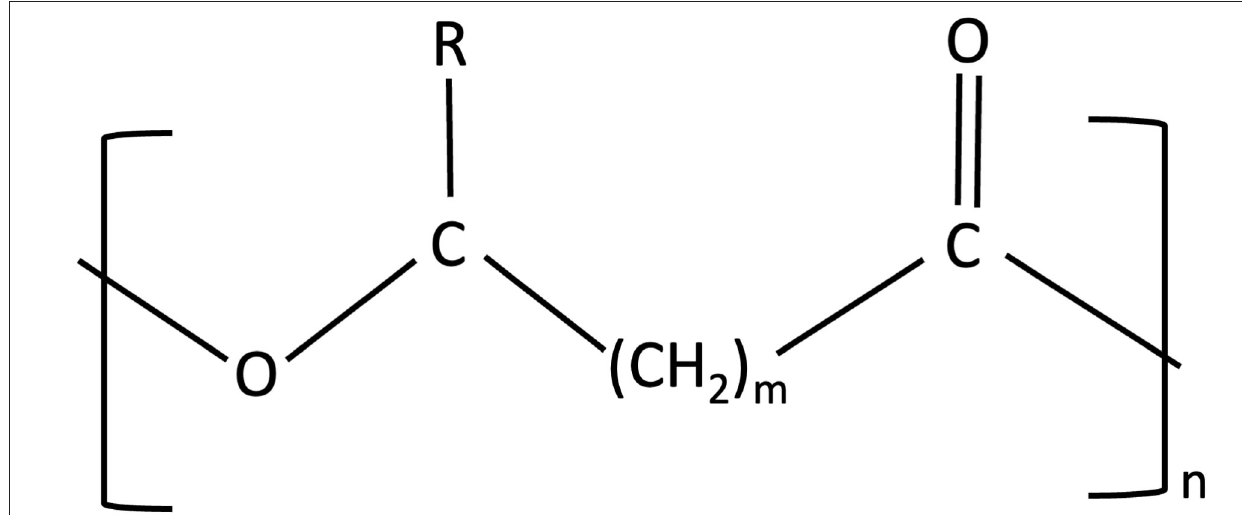
FIGURE 4 | Structure of PHAs (polyhydroxyalkanoates). In homopolymers, m can vary from 1 to 3 {polyhydroxybutyrate (PHB) - m = 1}, n can vary from 100 to 30,000 monomers, where R is a varied chain length alkyl group.